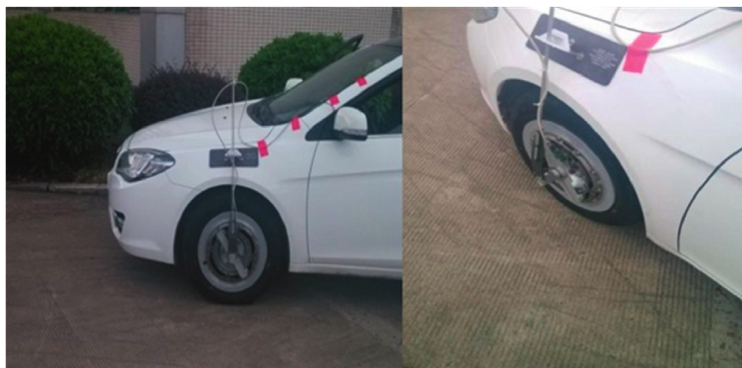
Figure 1: Installation of the six-component measuring system.